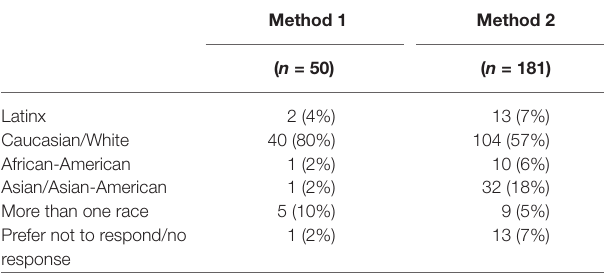
TABLE 1 | Child racial and ethnic distribution (Method 1–2).